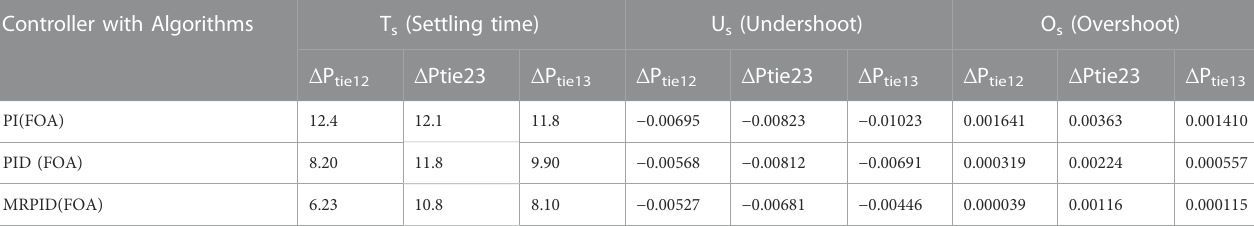
TABLE 4 Controller with algorithm for Δ P tie12, Δ P tie23 and Δ P tie13 . Controller with